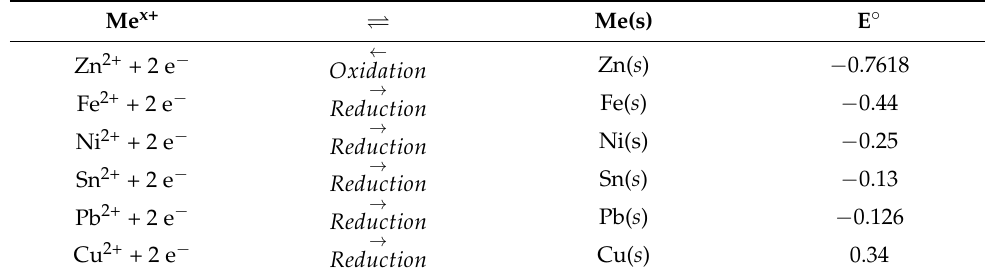
Table 6. Oxidation-reduction potentials of elements present in the CAF dust.